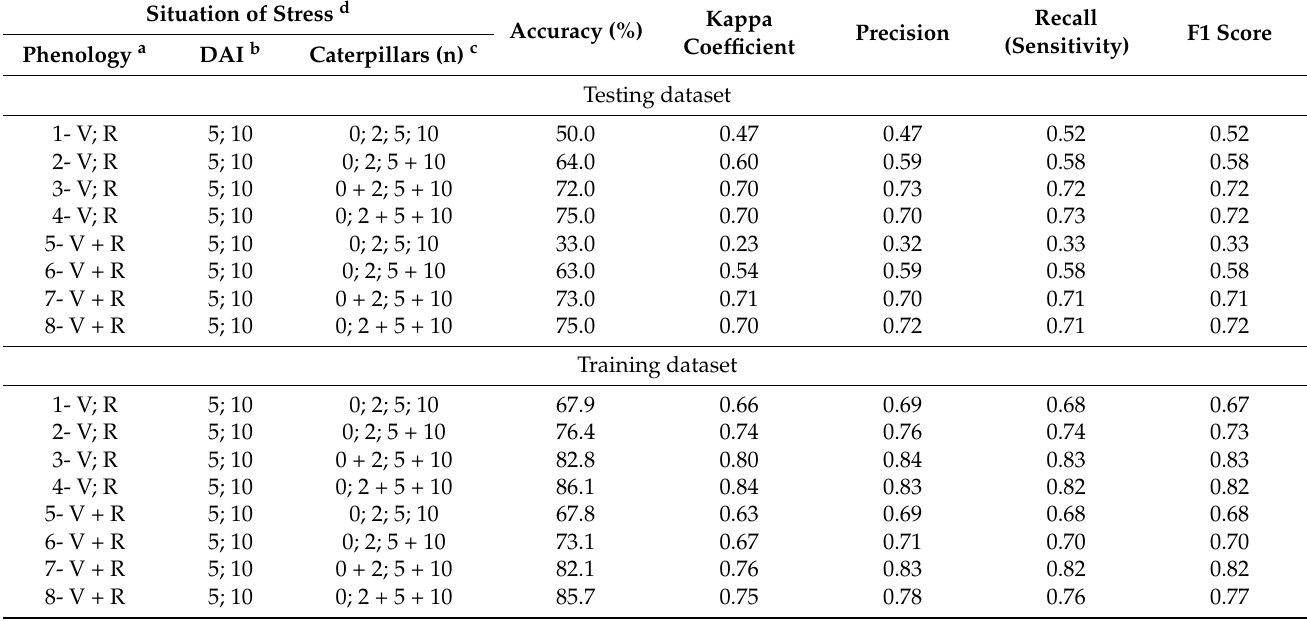
Table 4. Results for accuracy, Kappa coefficient, precision, recall, and F1 score for the testing and training datasets for discrimination of soybean plants under different situations of stress caused by C. includens based on multilayer perceptron artificial neural networks.